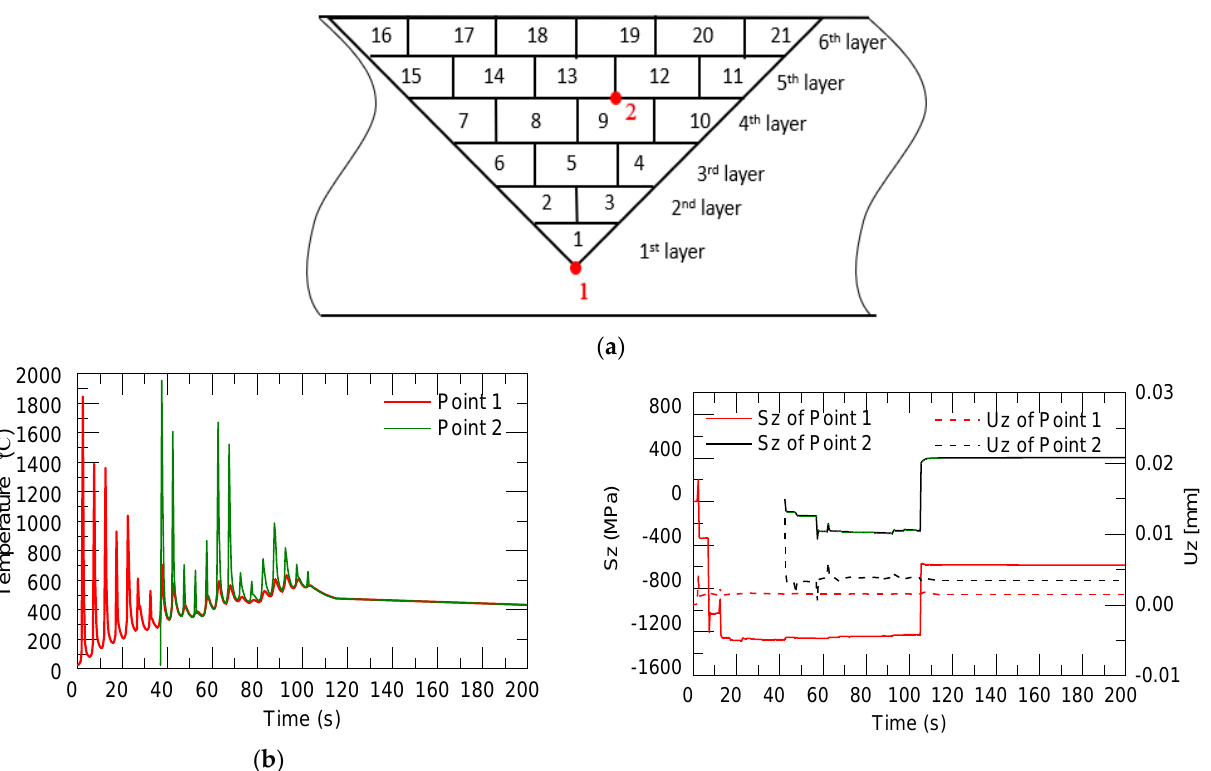
Figure 9. Location of points 1 and 2 ( a ). Curve graph of cycles in temperature ( b ), thermal stress and distortion ( c ) on the first and ninth track.